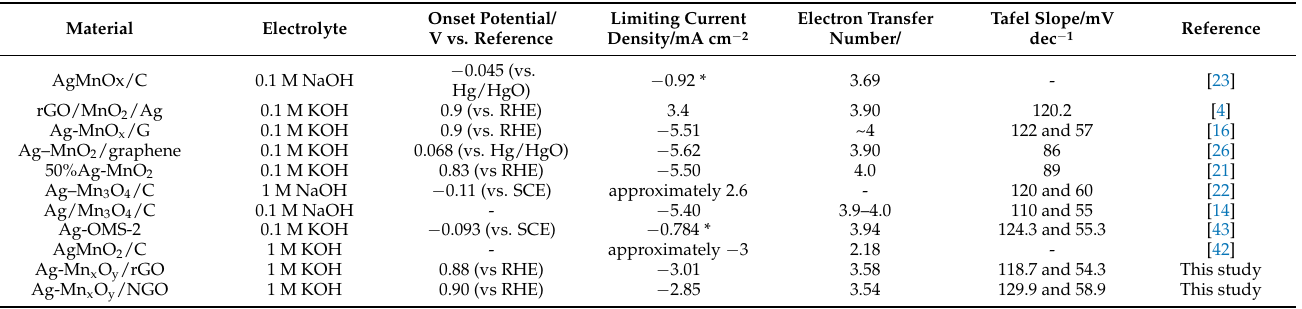
Table 4. Comparison of the ORR performances of various catalysts containing Ag and Mn x O y